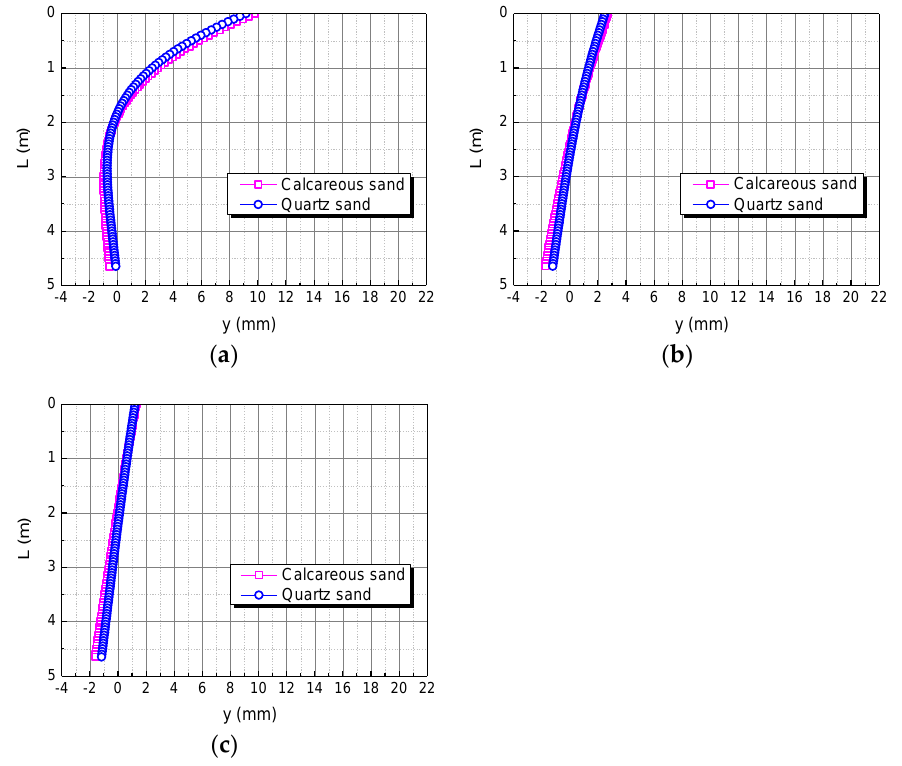
Figure 13. Effect of pile diameter on horizontal displacement of pile body. ( a ) D; ( b ) 2D; ( c ) 3D. 4.3. Comparison of Pile Elastic Modulus in Calcareous Sand and Quartz Sand Area The elastic modulus of the pile body is taken as E, 2E, and 3E, respectively. The influence of the elastic modulus of the pile body on the horizontal displacement of the pile body is shown in Figure 14. When the elastic modulus of the pile body is E, the horizontal displacement of the pile top in the calcareous sand area is 0.63122 mm larger than in the quartz sand area. When the elastic modulus of the pile body is 2E, the horizontal displacement of the pile top in the calcareous sand area is 0.80400 mm larger than in the quartz sand area. When the elastic modulus of the pile body is 3E, the horizontal displacement of the pile top in the calcareous sand area is 0.92964 mm larger than in the quartz sand area. The greater the elastic modulus of the pile body, the greater the difference between the two. It may be because the greater the elastic modulus of the pile body, the greater the stiffness of the pile body, which makes calcareous sand easier to compress than quartz sand.